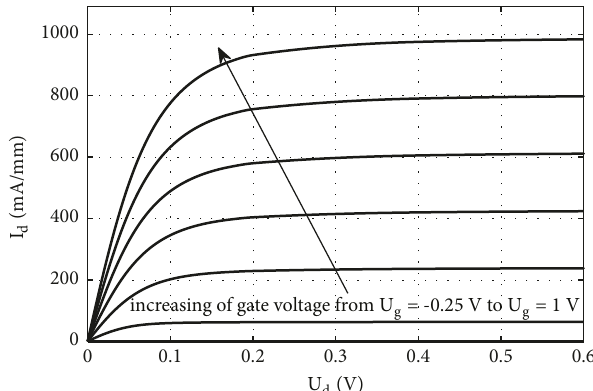
Figure 3: Current-voltage characteristics of AlGaAs/GaAs HEMT with 500 nm gate